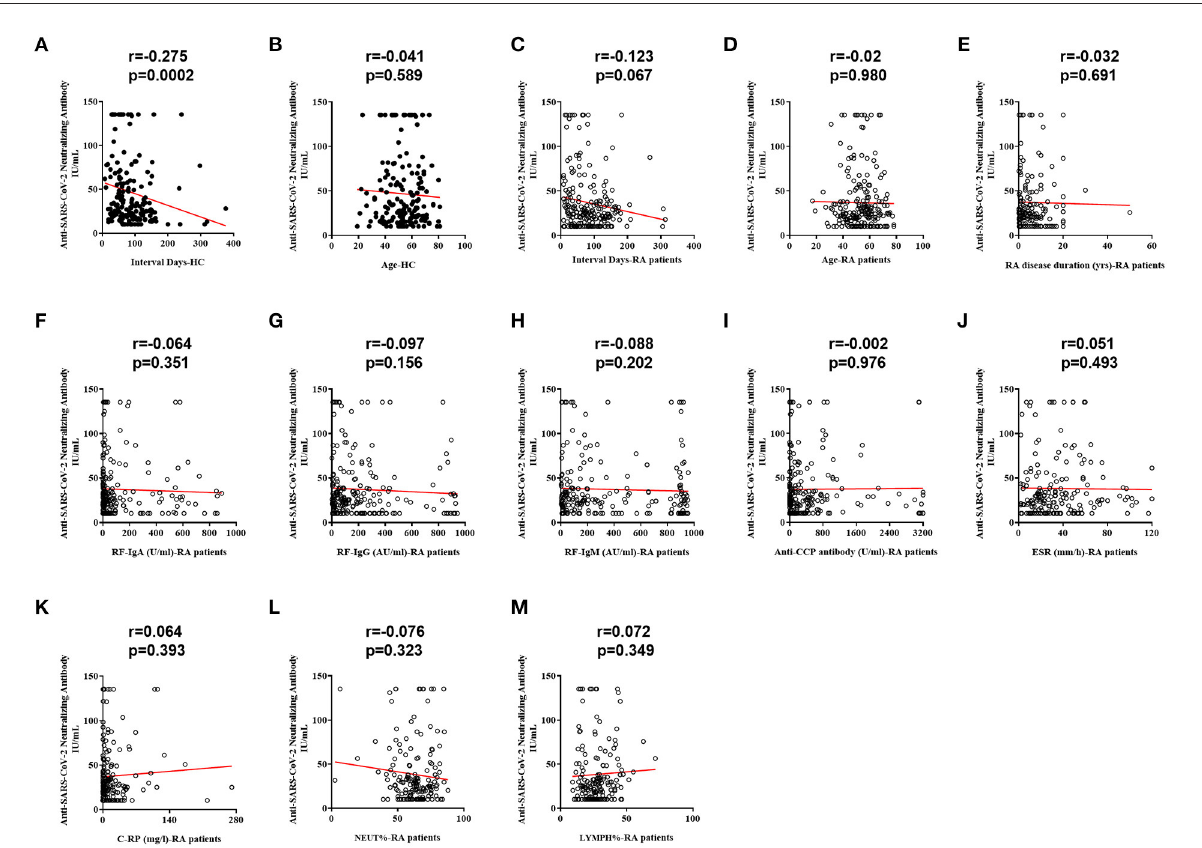
FIGURE3 Correlations between RA-related indicators and NAb titers. (A) Correlation between the interval time and NAb titers in HC. (B) Correlation between age and NAb titers in HC. (C) Correlation between the interval time and NAb titers. (D) Correlation between age and NAb titers in RA patients. (E) Correlation between disease duration and NAb titers in RA patients. (F) Correlation between RF-IgA and NAb titers in RA patients. (G) Correlation between RF-IgG and NAb titers in RA patients. (H) Correlation between RF-IgM and NAb titers in RA patients. (I) Correlation between anti-CCP antibody and NAb titers in RA patients. (J) Correlation between ESR and NAb titers in RA patients. (K) Correlation between C-RP and NAb titers in RA patients. (L) Correlation between NEUT% and NAb titers in RA patients. (M) Correlation between LYMPH% and NAb titers in RA patients.